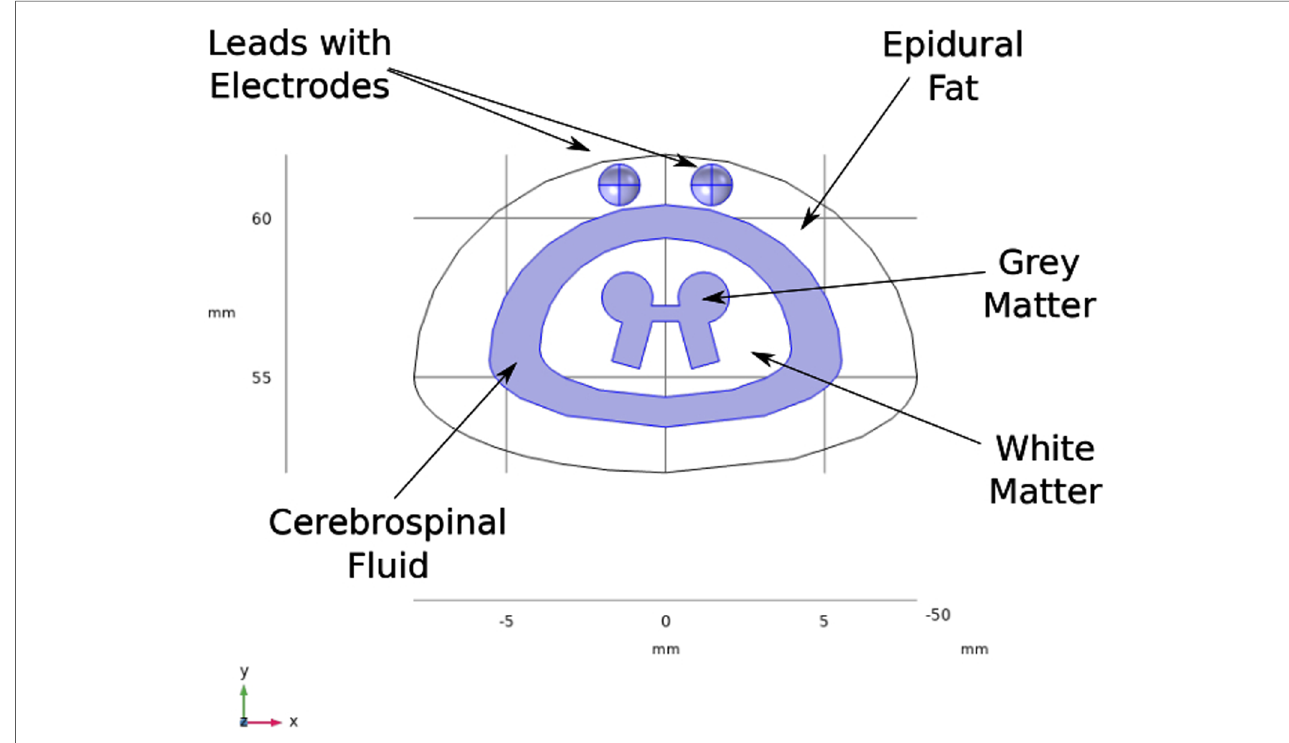
FIGURE 3 Cross-section of spinal cord. The leads are embedded in the epidural fat